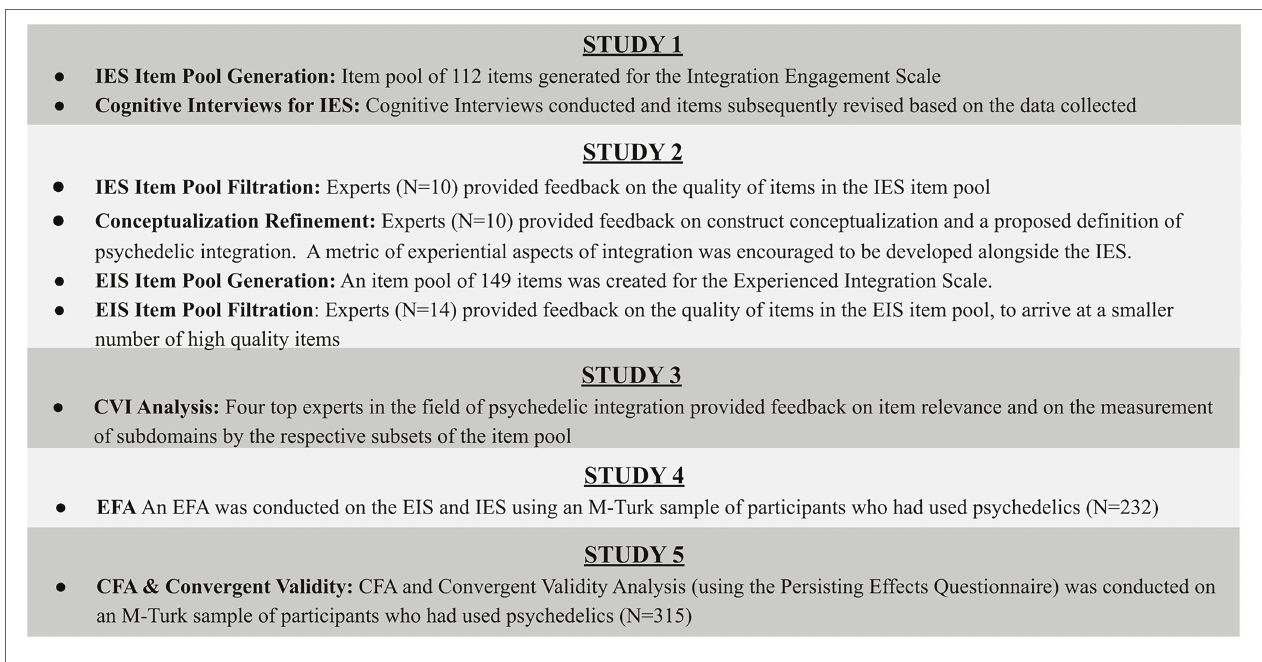
FIGURE 2 | Psychedelic integration scales developmental process